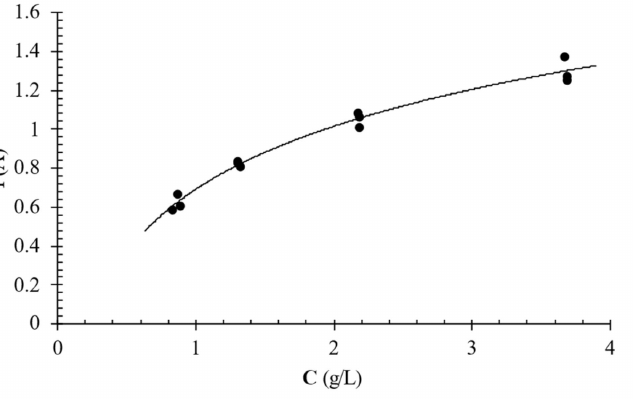
Figure 3. Limiting current intensity (I lim ) vs. solution citric acid concentration (C). The symbols refer to experimental data while the continuous lines refer to the approximating